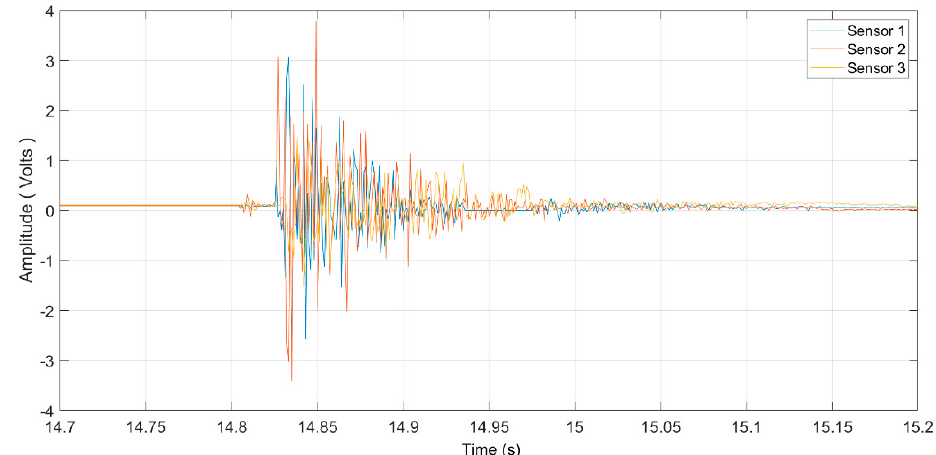
Figure 6. Example of the signal after filtering out the shift removal and the low-frequency noise (dewowing).